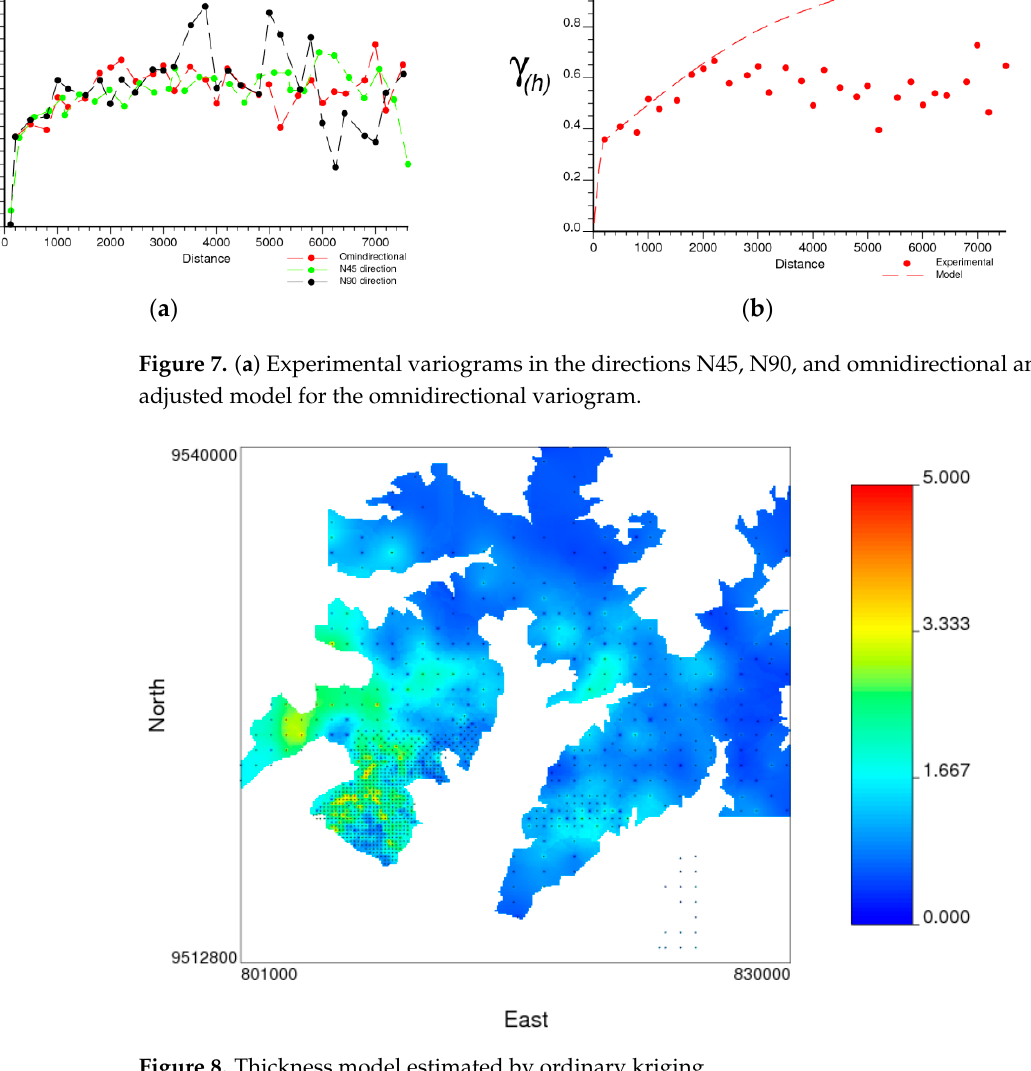
Figure 8. Thickness model estimated by ordinary kriging.